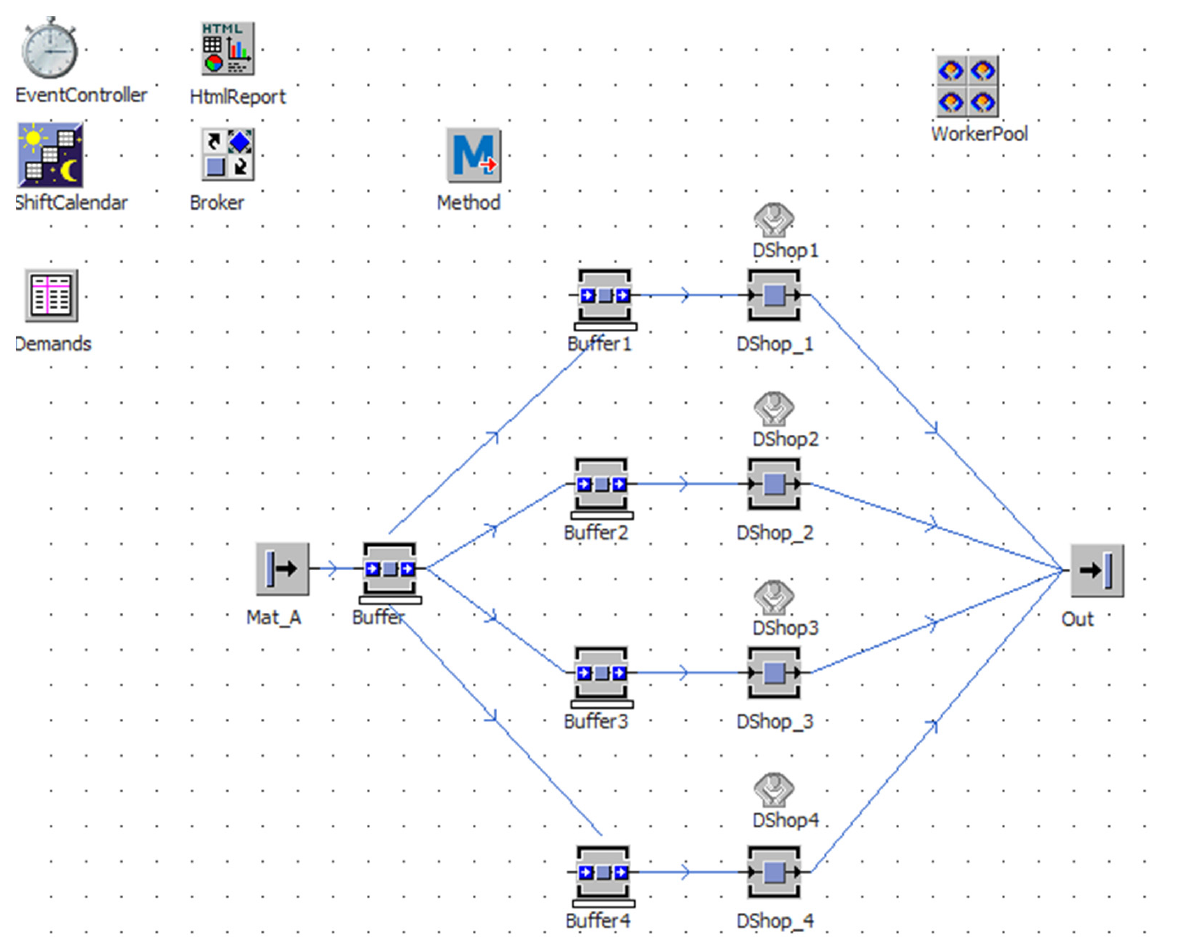
Figure 10. Simulation model of the proposed assembly process with D-Shops.